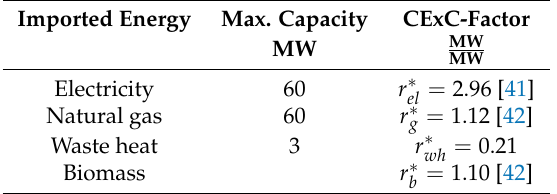
Table 1. Energy sources: grid connection capacities and CExC-factors.